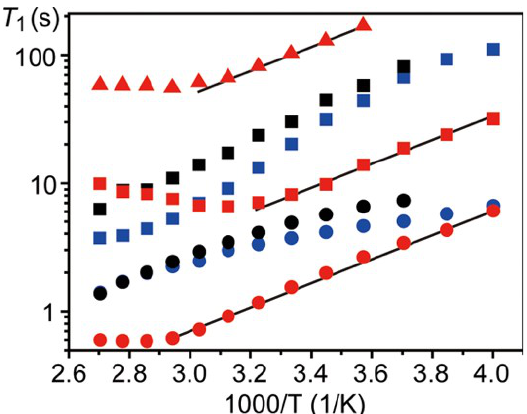
Figure 11. Plots of 6 Li (triangle), 7 Li (circle), and 31 P (square) T 1 ’s for 70 gc (red), 75 gc (blue), and 70 g (black). The solid line through 7 Li T 1 data points for 70 gc is the least-squares fit one to a straight line [36].